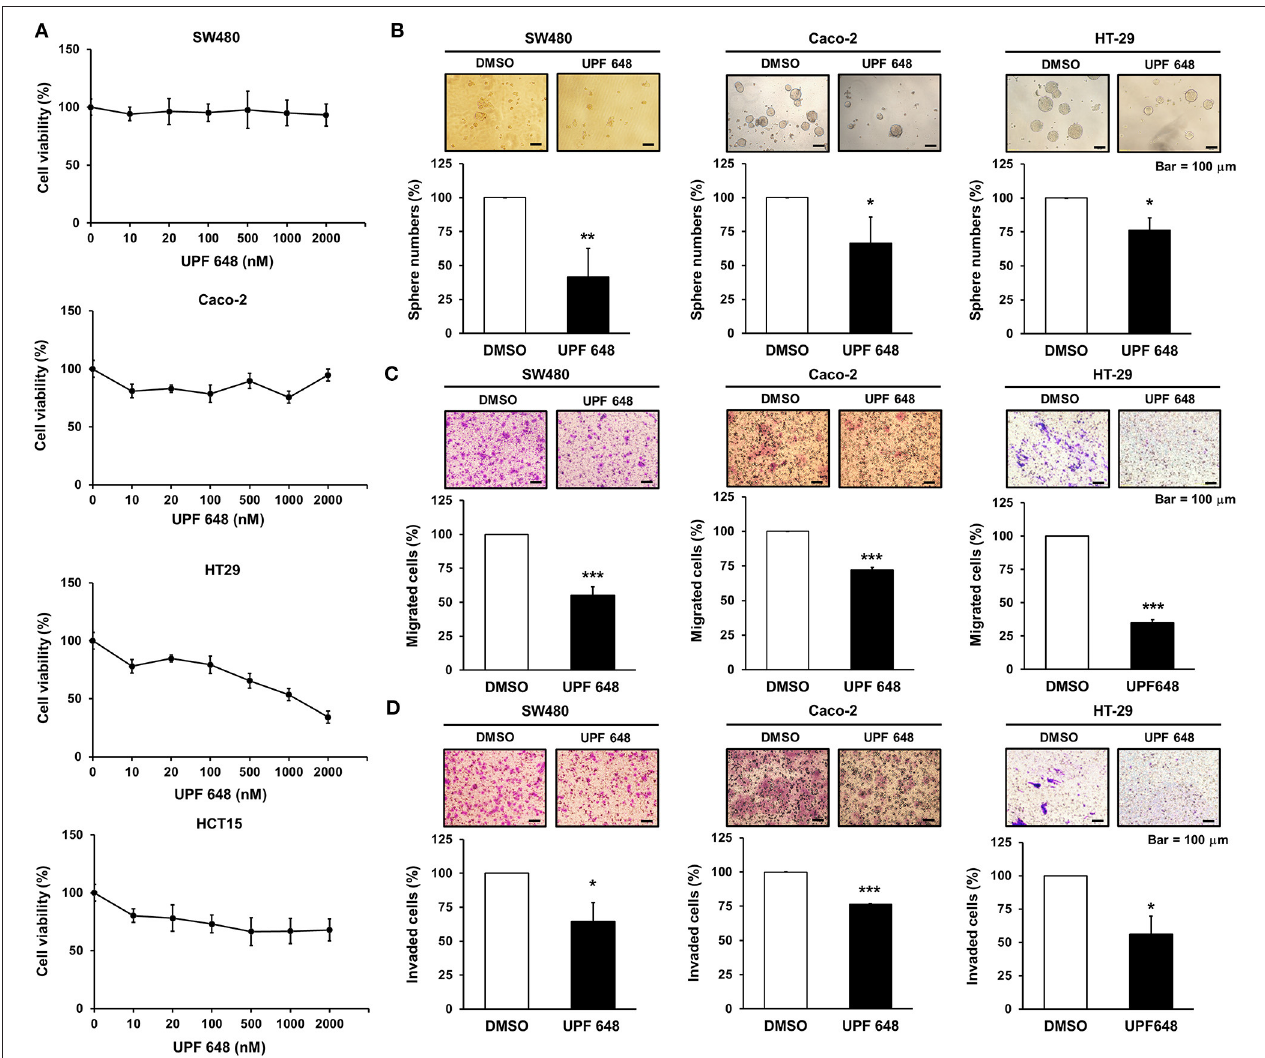
FIGURE 4 | KMO inhibitor reduces the abilities of sphere formation, migration, and invasion in CRC cells. (A) SW480, Caco-2, HT-29, and HCT-15 cells were treated with indicated doses of UPF 648 for 72h and examined by MTT assay. (B–D) SW480, Caco-2, and HT-29 cells treated with UPF 648 (1 µ M) or DMSO were seeded for sphere (B) , transwell migration (C) , and invasion assays (D) . Means ± SD of three independent experiments performed in triplicate are shown [100 magnification times for (C,D) ]. Student’s t -test, * P < 0.05; ** P < 0.01; *** P <